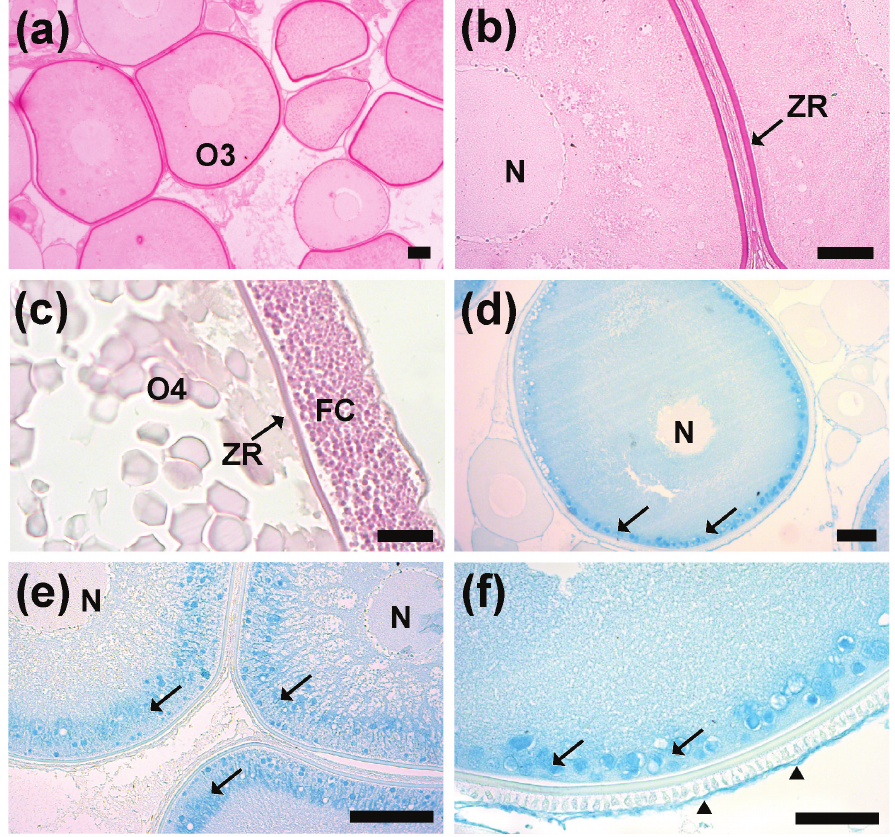
Figure 4 - Histochemical reaction in the H. francisci ovaries by periodic acid Schiff (PAS) a-c and Alcian Blue (AB), pH 2.5 d-f. (a) pre-vitellogenic oocyte (O3). (b) zona radiata (ZR) PAS-positive and nucleus of pre-vitellogenic oocyte (N). (c) zona radiata and follicular cells (FC)